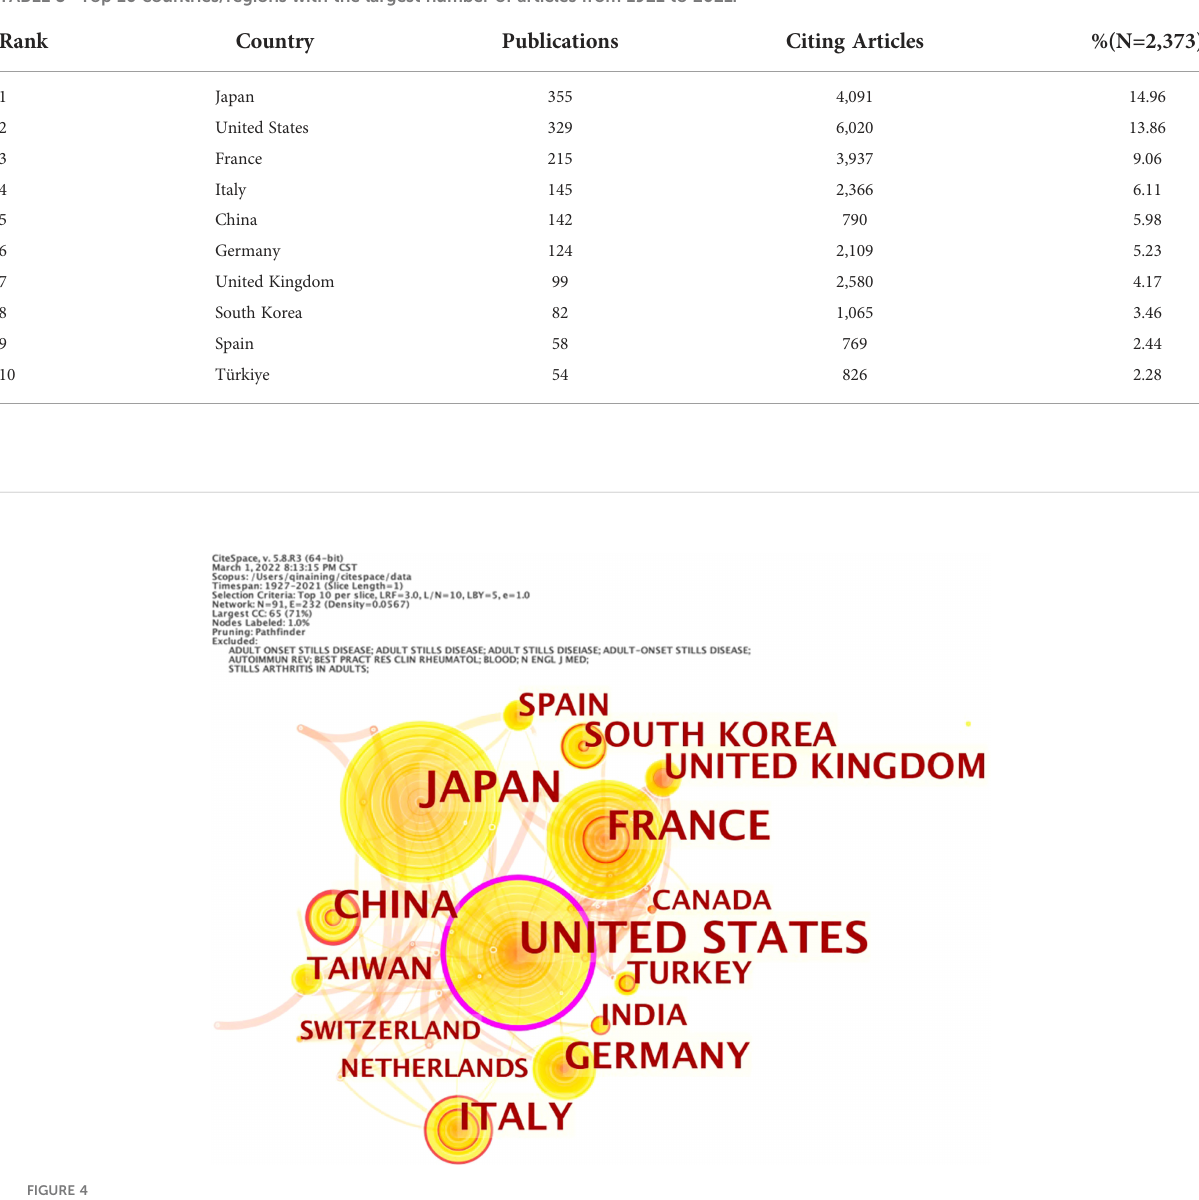
FIGURE 4 Network of cooperation among countries/regions of adult-onset Still ’ s disease articles from 1921 to 2021.